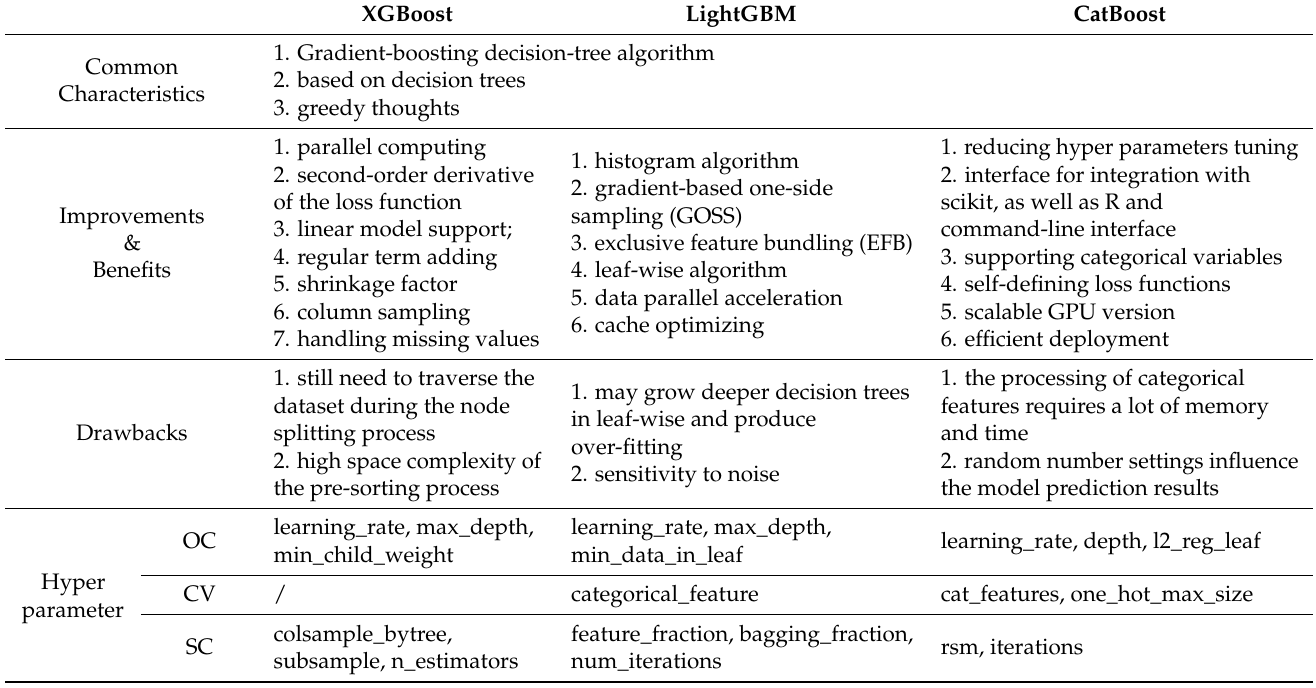
Table 1. The main characteristics and important parameters of XGBoost, LightGBM, and CatBoost. XGBoost LightGBM